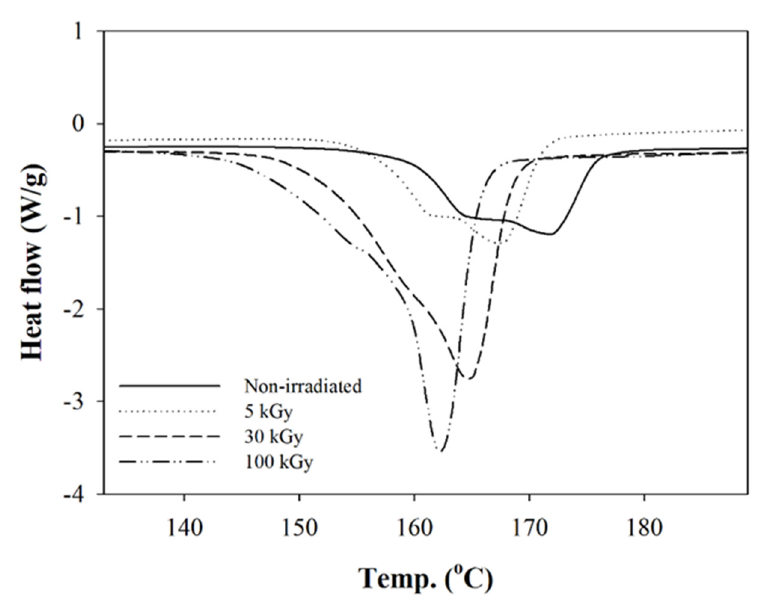
ff erent irradiation